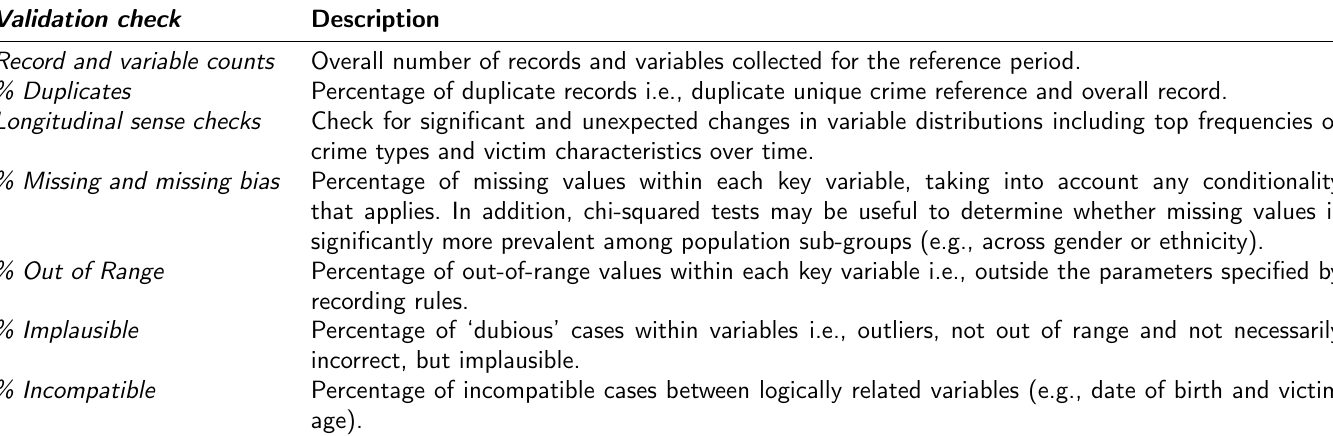
Table 7: Proposed accuracy validation checks for AF